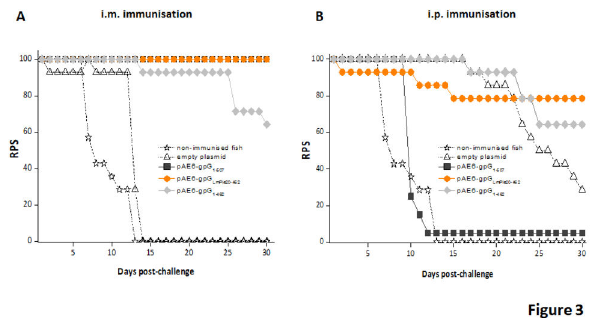
Figure 3. Protection against VHSV challenge conferred after DNA immunisation. Fish were immunised with each of the plasmid constructs intramuscularly (A) or intraperitonearly (B) in separated tanks. The challenge was carried out at 40 days after DNA immunisation, and mortality recorded for 30 days. Values are shown as Relative Percentage of Survival (RPS). doi: